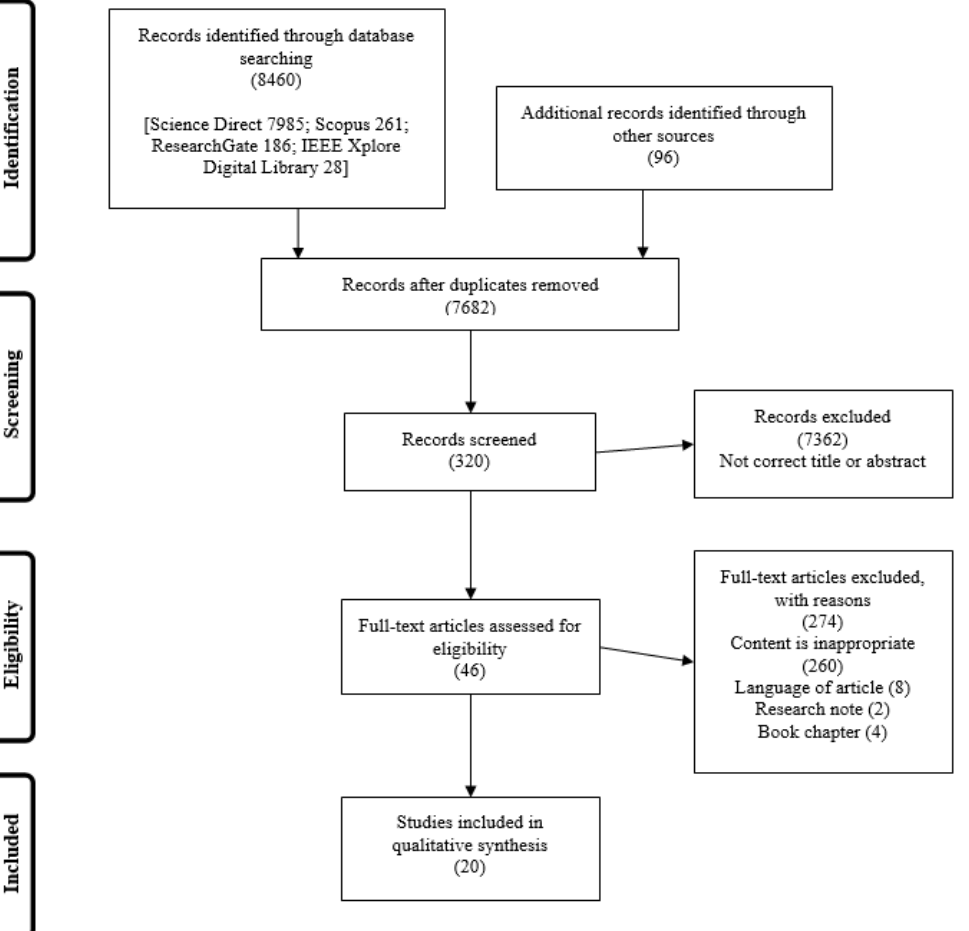
Fig. 1. PRISMA flow diagram for literature search (made by the